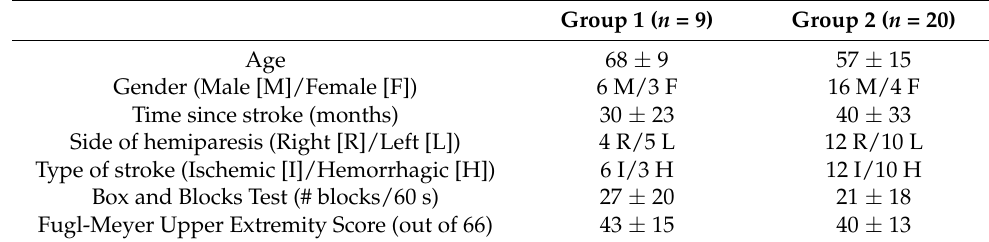
Table 1. Stroke survivors’ demographics for the HAND algorithm ( ± for standard